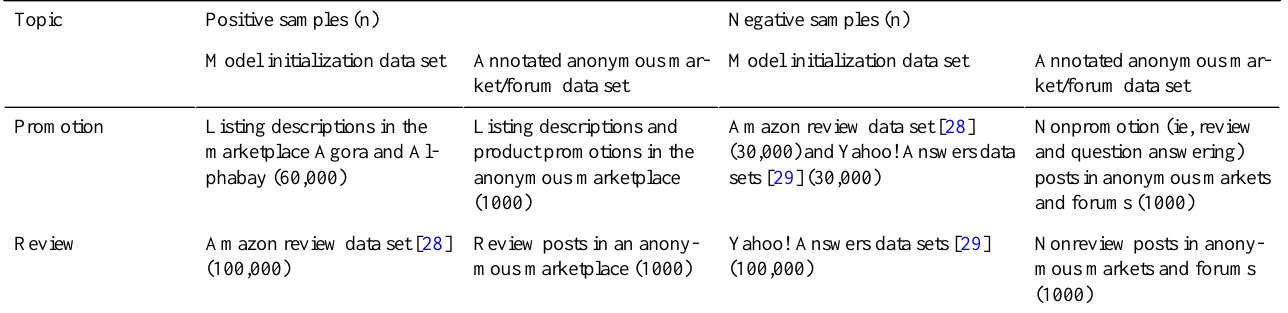
Table 3. Data sets used in the forum post modeling.